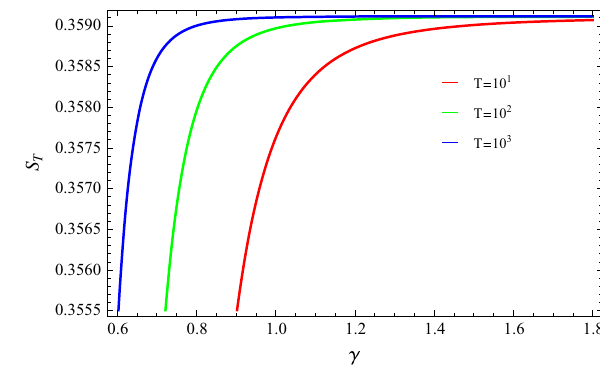
Fig. 4 Plots of total entropy versus